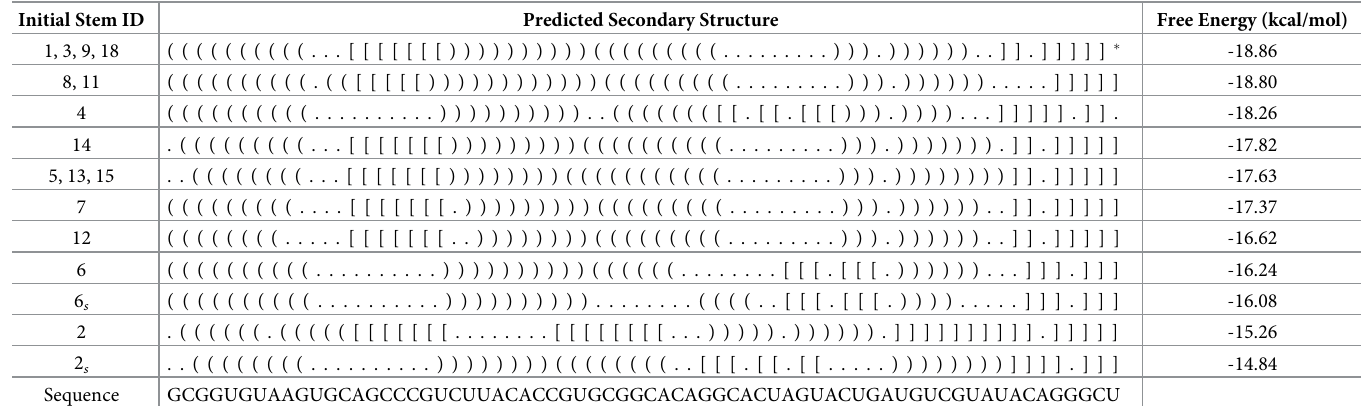
Table 5. Predicted secondary structures for the SARS-CoV-2 − 1 PRF stimulating pseudoknot based on the reference sequence. These structures are predicted by Itera- tive HFold given the initial stems in Table 4 as structural constraints. Certain suboptimal structures (e.g. 6 s and 2 s , cf. Fig 4) are reported, because in these cases the struc- ture has only slightly higher free energy than the minimum free energy structure predicted by Iterative HFold. Native structure is marked with an asterisk ( � ) in row 1. As shown in rows 1, 2 and 5 of the table, multiple initial stems can result in a single prediction for the − 1 PRF stimulating pseudoknot. Input sequence is provided in the bot- tom row.